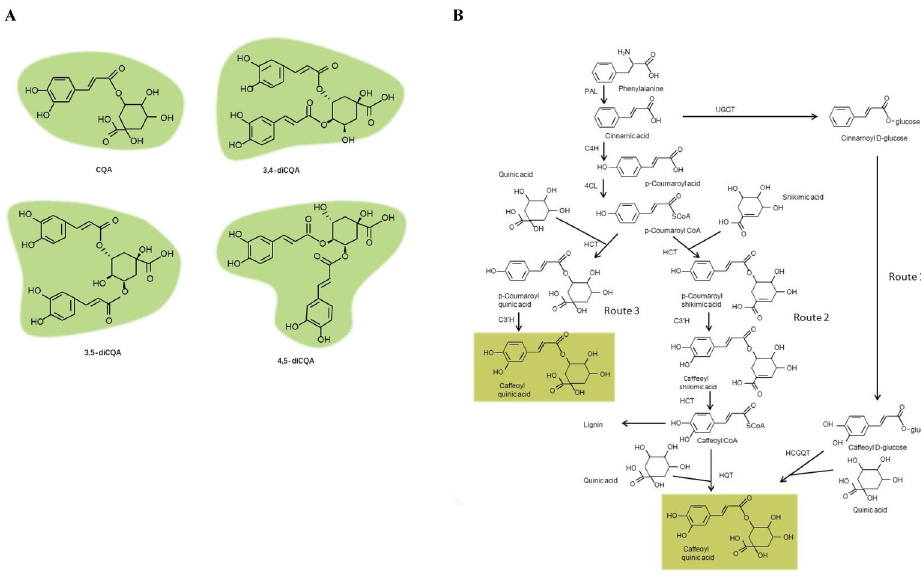
Fig 1. Specialized CGAs found in leafy sweet potato. (A) Structures of major CGAs. (B) The proposed pathway responsible for the CGA biosynthesis